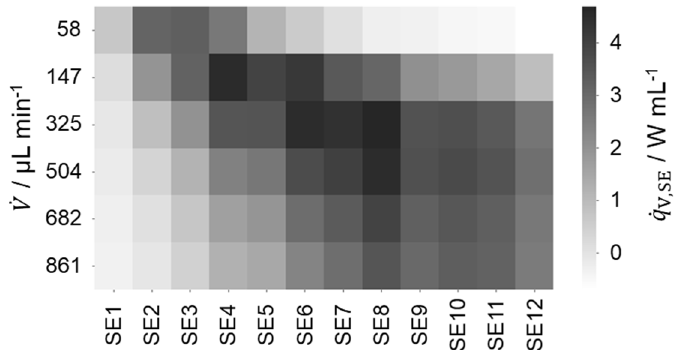
Figure 7. Specific heat flux profile of the SEs for the hydrolysis of acetic anhydride for varying volumetric flow rate and T in = T ambient = 30 °C